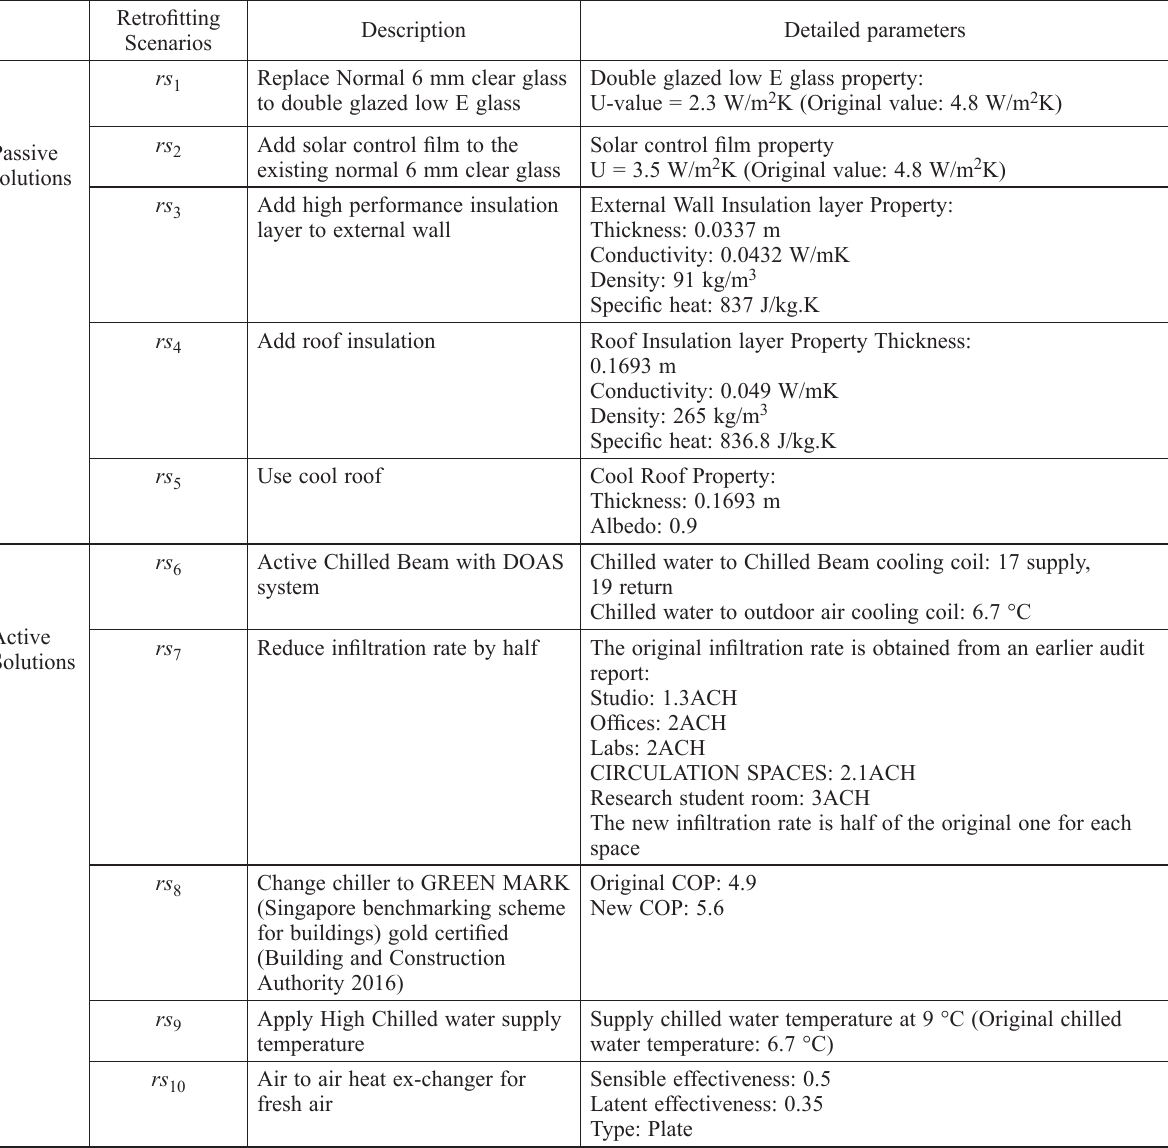
Table 2. Selected retrofitting scenarios and detail parameters in the various retrofitting